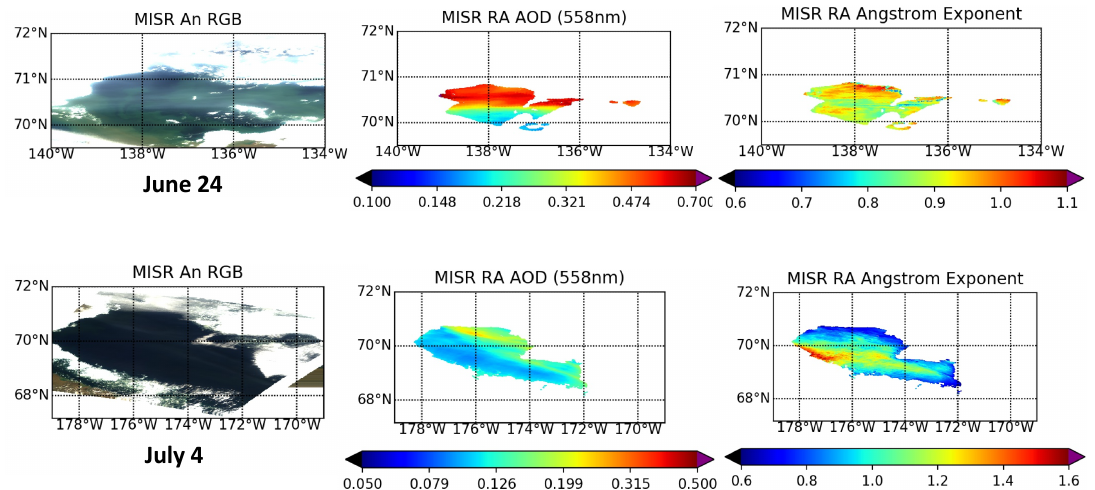
Figure 6. Aerosol properties retrieved with the MISR research algorithm (RA) for cloud-free oceanic scenes in the Arctic on June 24 ( top ) and 4 July 2009 ( bottom